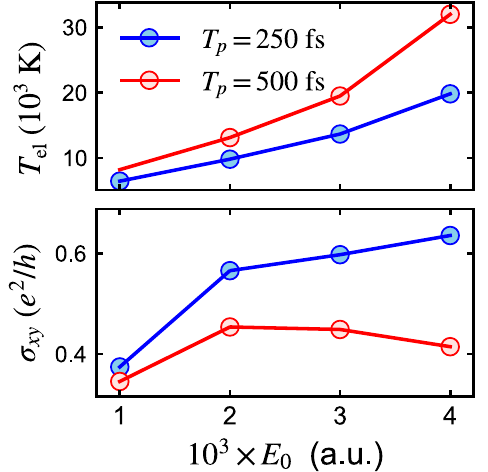
FIG. 5. Upper panel: electronic temperature T obtained from el the single-temperature model (11) for pump-pulse duration T p ¼ 250 fs (blue) and T 500 fs (red) as a function of the pump p ¼ field strength E 0 . Lower panel: corresponding Hall